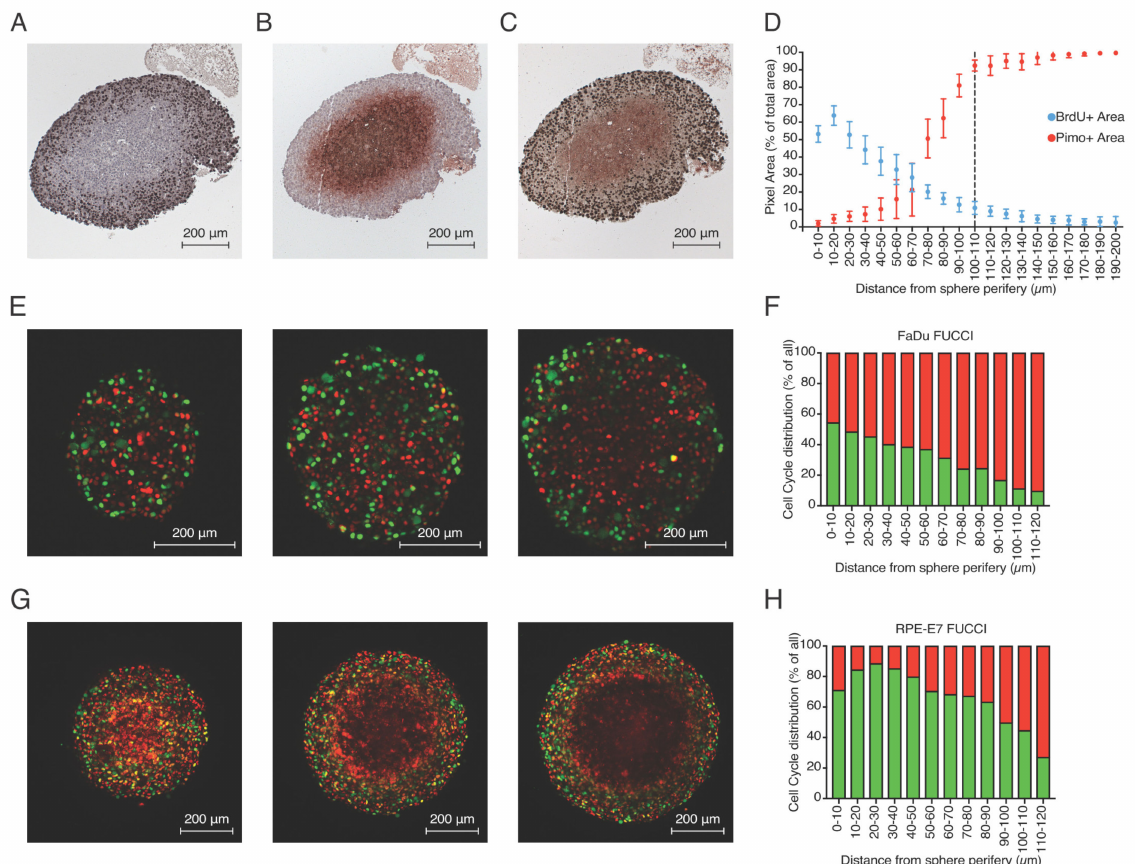
Figure 6. Proliferation and hypoxia profile in multicellular spheroids. ( A – C ) Characteristic staining of three consecutive central cross-sections (3 µ m distance between them) of FaDu spheroids stained for BrdU-positive cells ( A ), pimonidazole- positive area ( B ) and double staining ( C ). ( D ) Quantification of BrdU and pimonidazole signal over different distances from the outer rim of the multiple spheroids on central cross-sections of FaDu shperoids where the anti-correlation of the two parameters is depicted. ( E ) 2-photon microsopy image of FaDu-FUCCI spheroid cross-sections at different z-levels are depicted (extracted from Supplementary Video S1). ( F ) 3-D quantification of fraction of FUCCI- expressing cells location in relation to the outer rim in FaDu-FUCCI multicellular spheroids. ( G ) 2-photon microsopy image of RPE-E7-FUCCI spheroid cross-sections at different z-levels are depicted (extracted from Supplementary Video S2). ( G ) 3-D quantification of the percentage of FUCCI-expressing cells from the outer rim in FaDu FUCCI multicellular spheroids. ( H ) 3-D quantification of the percentage of FUCCI-expressing cells from the outer rim in RPE-E7 FUCCI multicellular